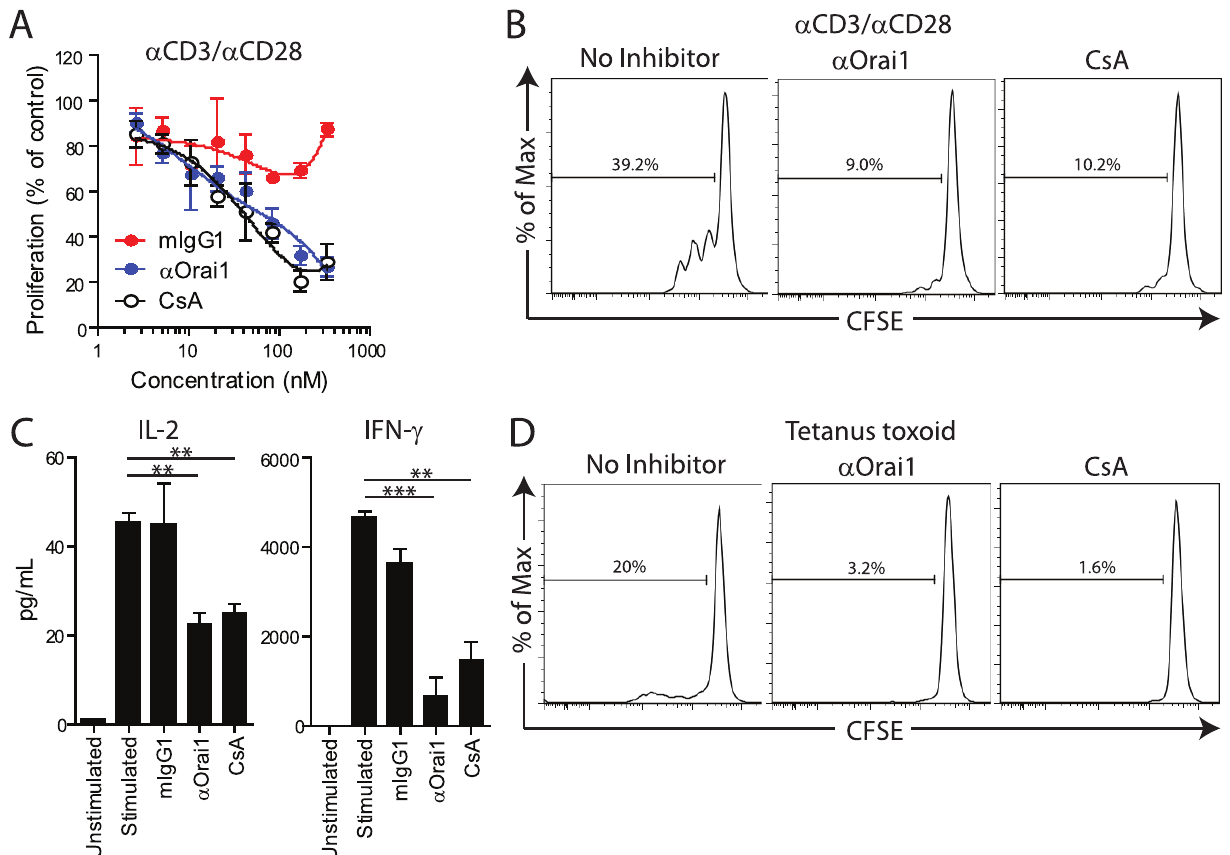
Figure 4. Anti-Orai1 antibody inhibits T cell response and proliferation. A ) Proliferation of PBMCs treated with a CD3/ a CD28 in the presence of control mIgG1, a Orai1, or cyclosporine A (CsA). Data is calculated as percentage of CFSE-diluted cells in the absence of inhibitor. B ) Representative CFSE dilution traces of a CD3/ a CD28-treated PBMCs without inhibitor, or with 333 nM CsA or a Orai1 (equivalent to 50 m g/mL). FACS plots are gated on viable CD5 + T cells. C ) Effect of treatment with 20.8 nM CsA or a Orai1 (equivalent to 3.1 m g/mL) on IL-2 and IFN- c production at 16 and 72 h, respectively, following stimulation with a CD3/ a CD28. D ) Representative CFSE dilution traces of tetanus toxoid-induced proliferation of PBMCs. FACS plots are gated on viable CD3 + CD4 + T cells. **P , 0.01, ***P , 0.001. Panels A–C are representative of three independent experiments (each with at least two donors) and panel D is from a single experiment.